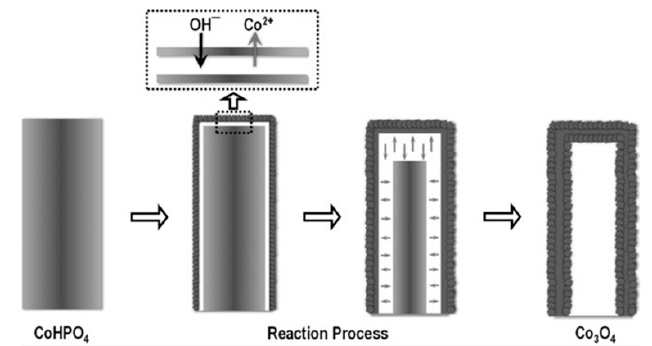
Figure 14. Co 3 O 4 ‐ MTA formation scheme from the CoHPO 4 precursor. Reproduced from [48], with permission from John Wiley and Sons, copyright 2017.